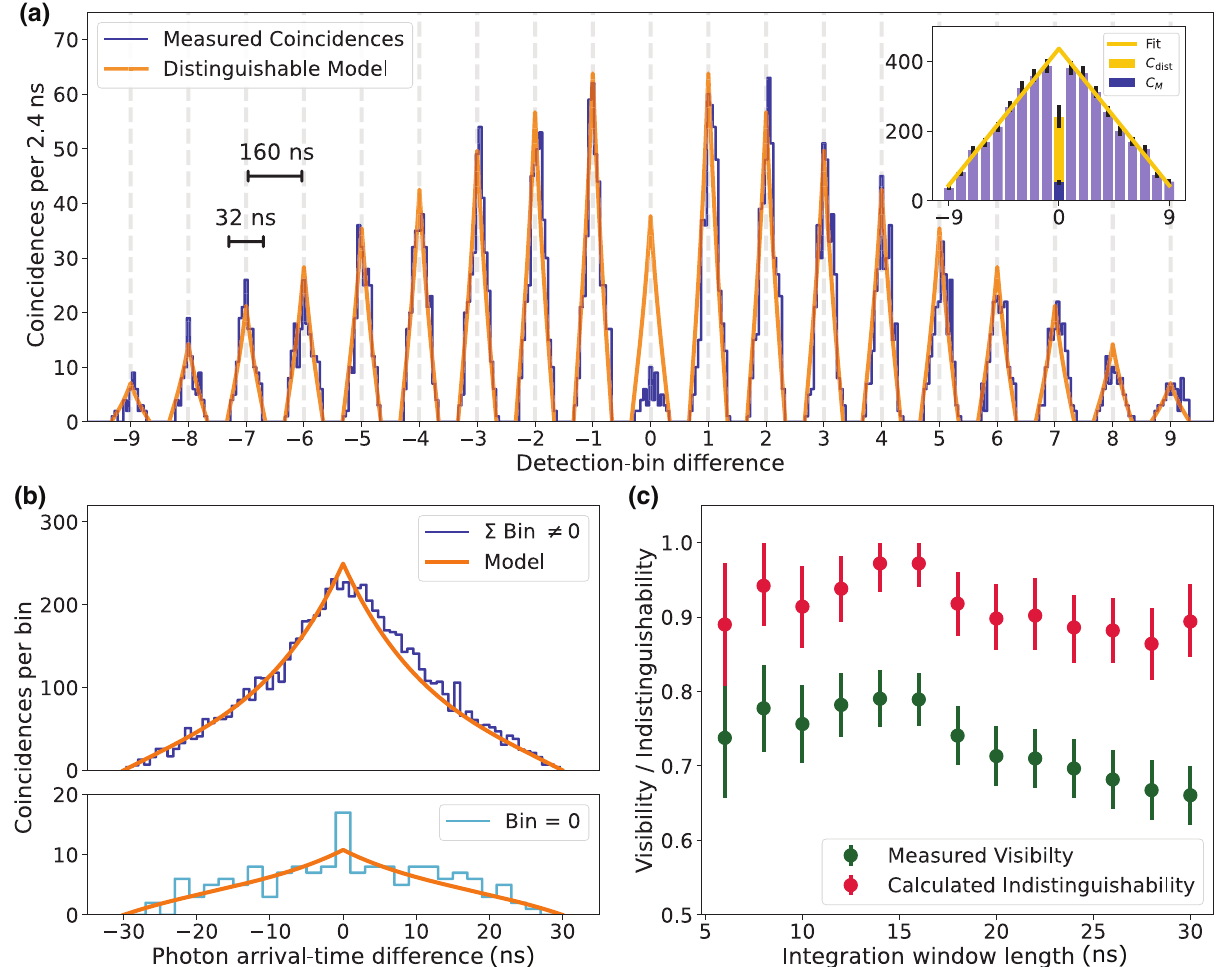
FIG. 4. Two-photon quantum interference at telecom wavelength. (a) The histogram of the measured coincidences (blue) for the analyzed time bins, overlaid with a model assuming distinguishable photons (orange), based on independently determined parameters. The histogram bin size is 2.4 ns. The vertical lines depict the time origin of each detection-bin difference. The horizontal scale bars show the relevant time scales in and between the detection-bin difference. The inset shows the extraction of the interference visibility, corrected for the imbalance of measured photons per excitation of the two nodes, using a linear fit to the total counts per bin difference (see text). (b) A histogram showing the temporal shape of the nonzero (zero) bin-difference coincidences shown in the top (bottom) panel. We overlay the data with the same model (see the Supplemental Material [25]), taking into account brightness and background rates and the indistinguishability of converted NV photons of 0.9 [see (c)]. The bin size for the top (bottom) panel is 0.8 ns (2 ns). (c) The measured visibility and extracted indistinguishability of converted NV photons for varying window length. The error bars for visibility and indistinguishability are 1 σ and a 68% confidence interval, respectively. The green (blue) circled points indicate data corresponding to the window length shown in Fig. 4(a) [Fig.